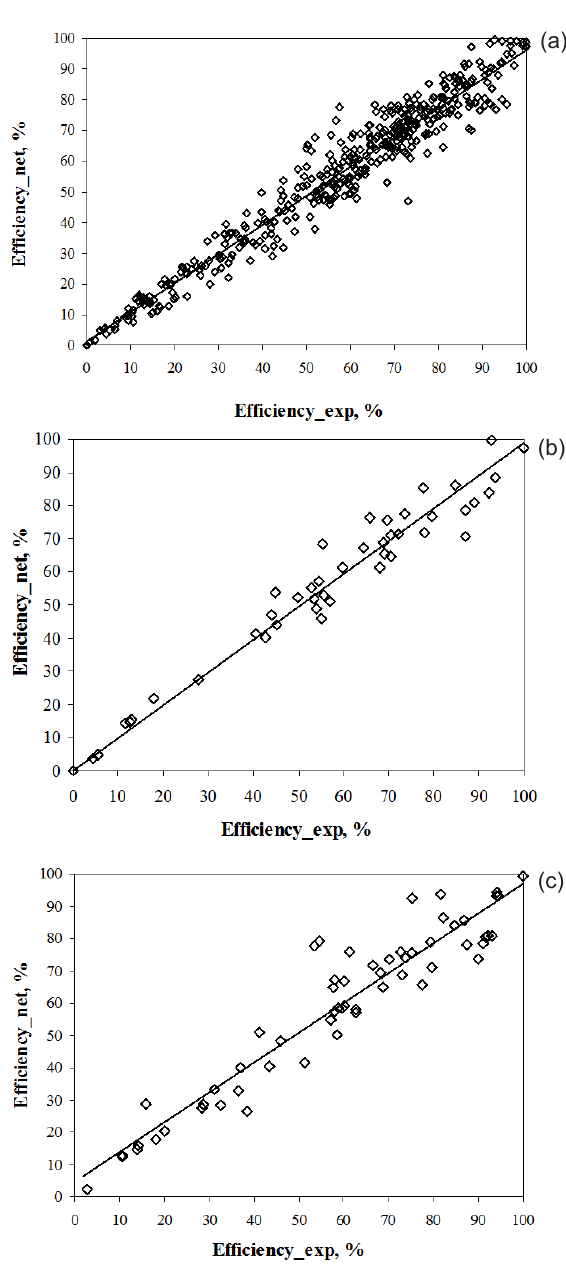
Figure 1. The efficiency of the process obtained experimentally and by neural network modelling, based on TanhAxon as transfer function, in the training (a), validation (b), and testing (c)